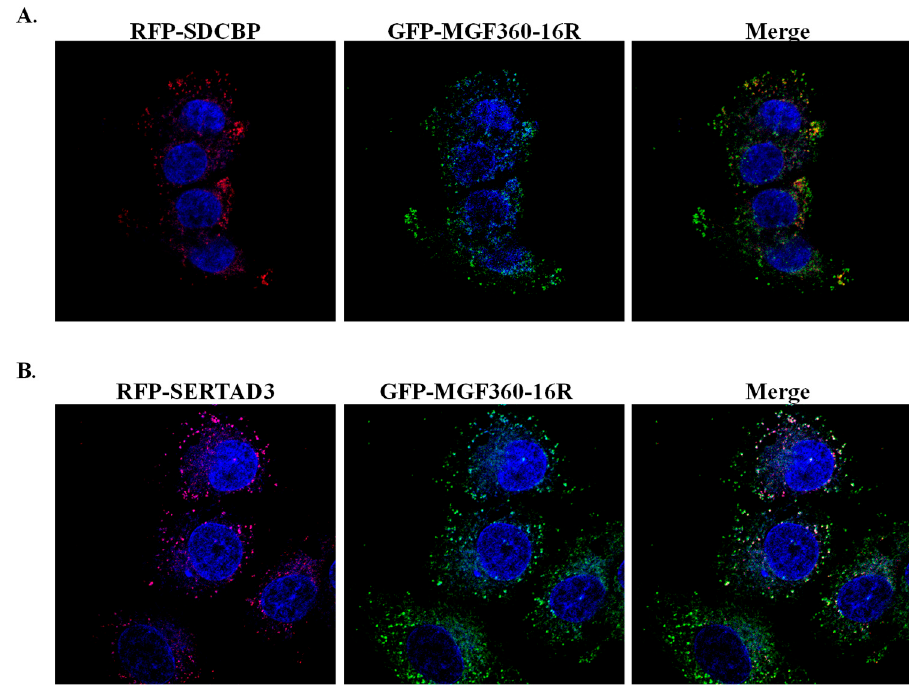
Figure 4. Protein–protein interaction of ASFV MGF360-16R with swine SERTA domain containing 3 (SERTAD3) and syndecan-binding protein (SDCBP) in the yeast two-hybrid system. Spots of strains, 10 µ L, expressing the indicated constructs containing 2 × 10 6 yeast cells were spotted on selective media (top panel) for protein–protein interaction in the yeast two-hybrid system, SD–Ade / His / Leu / Trp plates (-ALTH), and nonselective media (bottom panel) SD–Leu / Trp (-LT) for plasmid maintenance only.